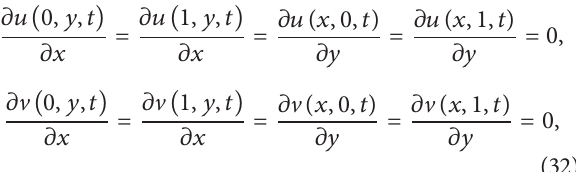
and Neumann boundary